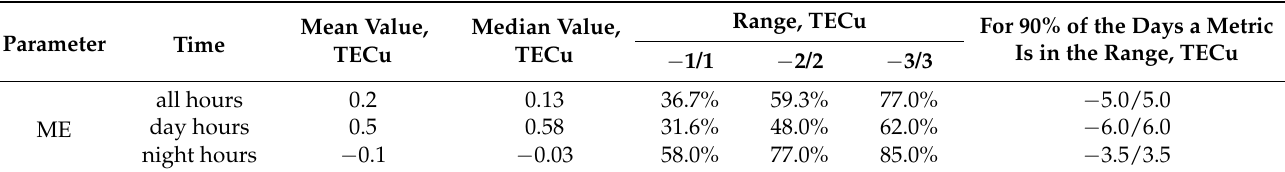
Table 7. Mean and median values and the percentage in a certain range for the MAE and RMSE scores for ME(L31, mean.lag1.2) model.